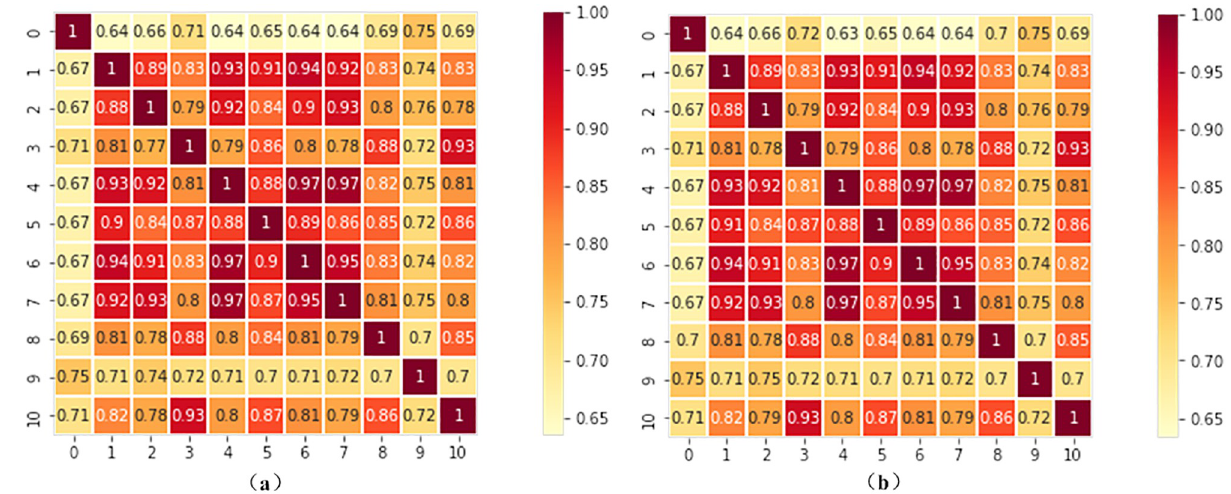
Fig 4. Correlation analysis between the incidence of hepatitis E and meteorological factors. (a) GRA heat map on the incidence of hepatitis E; (b) GRA heat map on the cases of hepatitis E.